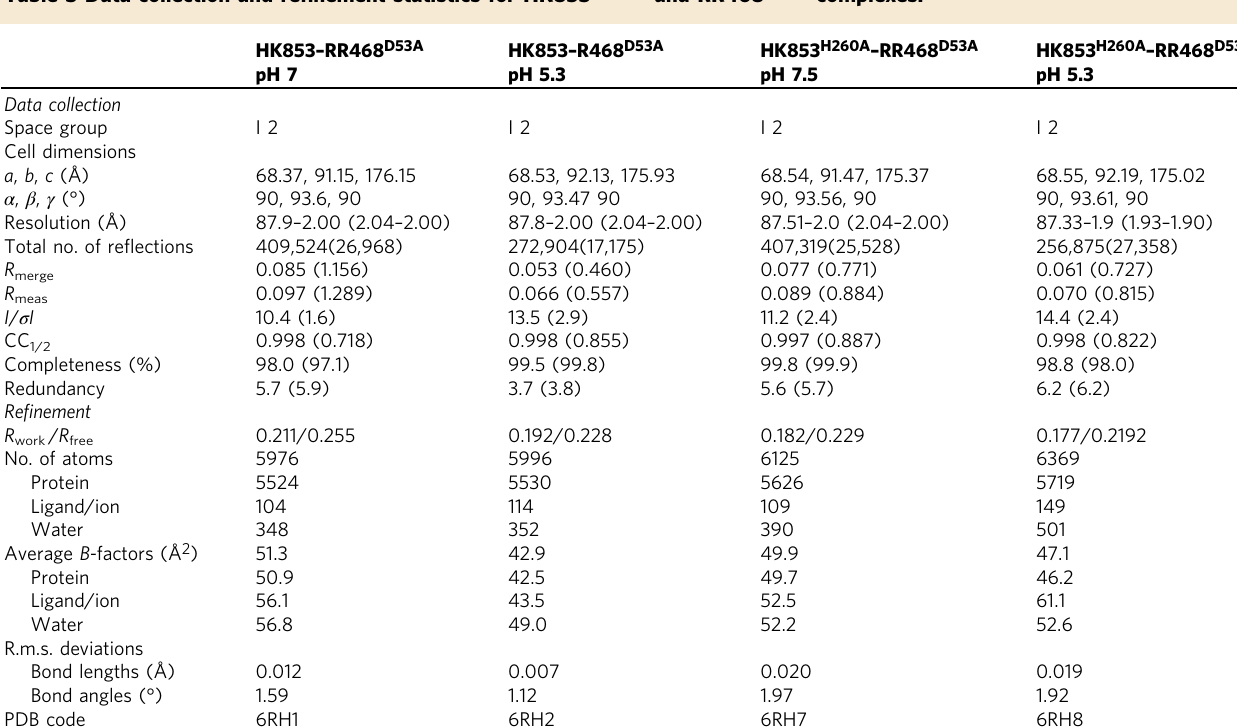
Table 3 Data collection and re fi nement statistics for HK853 H260A and RR468 D53A